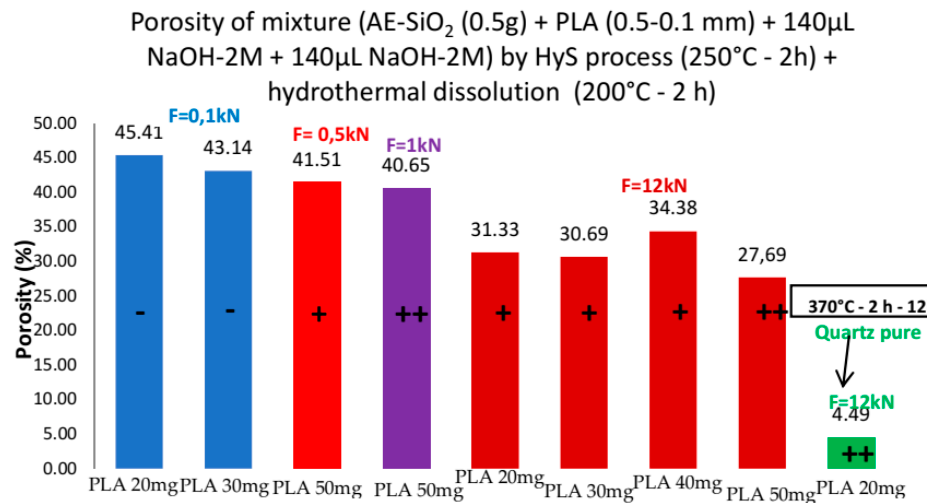
Figure 6. Porosity of AE SiO 2 by hydrothermal dissolution.